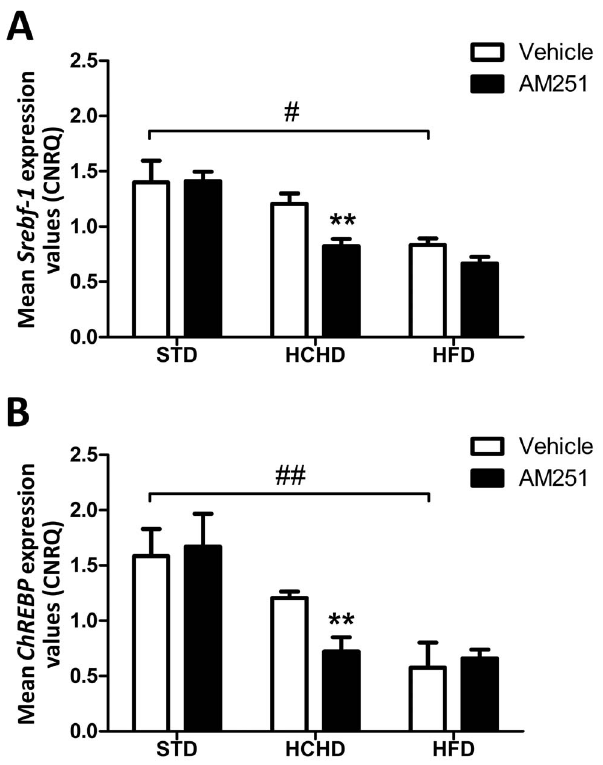
Figure 4. Effect of obesogenic diets and AM251 on the Srebf-1 and ChREBP gene expression in PrAT. The gene expression of Srebf- 1 ( A ), and ChREBP ( B ), was determined in PrAT of STD, HCHD or HFD-fed animals after 14-day exposure to vehicle or AM251 (3 mg/kg, daily, i.p.). Columns are CNRQ means 6 SEM (n=8 animals per group). Differences between diets were analyzed by one-way ANOVA and Bonferroni’s post- hoc test, and comparisons between groups treated with AM251 or vehicle were analyzed by Student’s t test. # p , 0.05, ## p , 0.01 denote significant differences compared with the STD-fed group vehicle- treated. ** p , 0.01 denote significant differences compared with the corresponding vehicle-treated group.